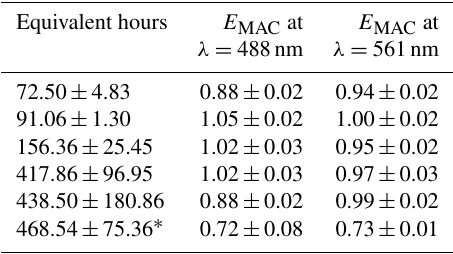
Table 3. E MAC (488nm) and E MAC (561nm) for OH